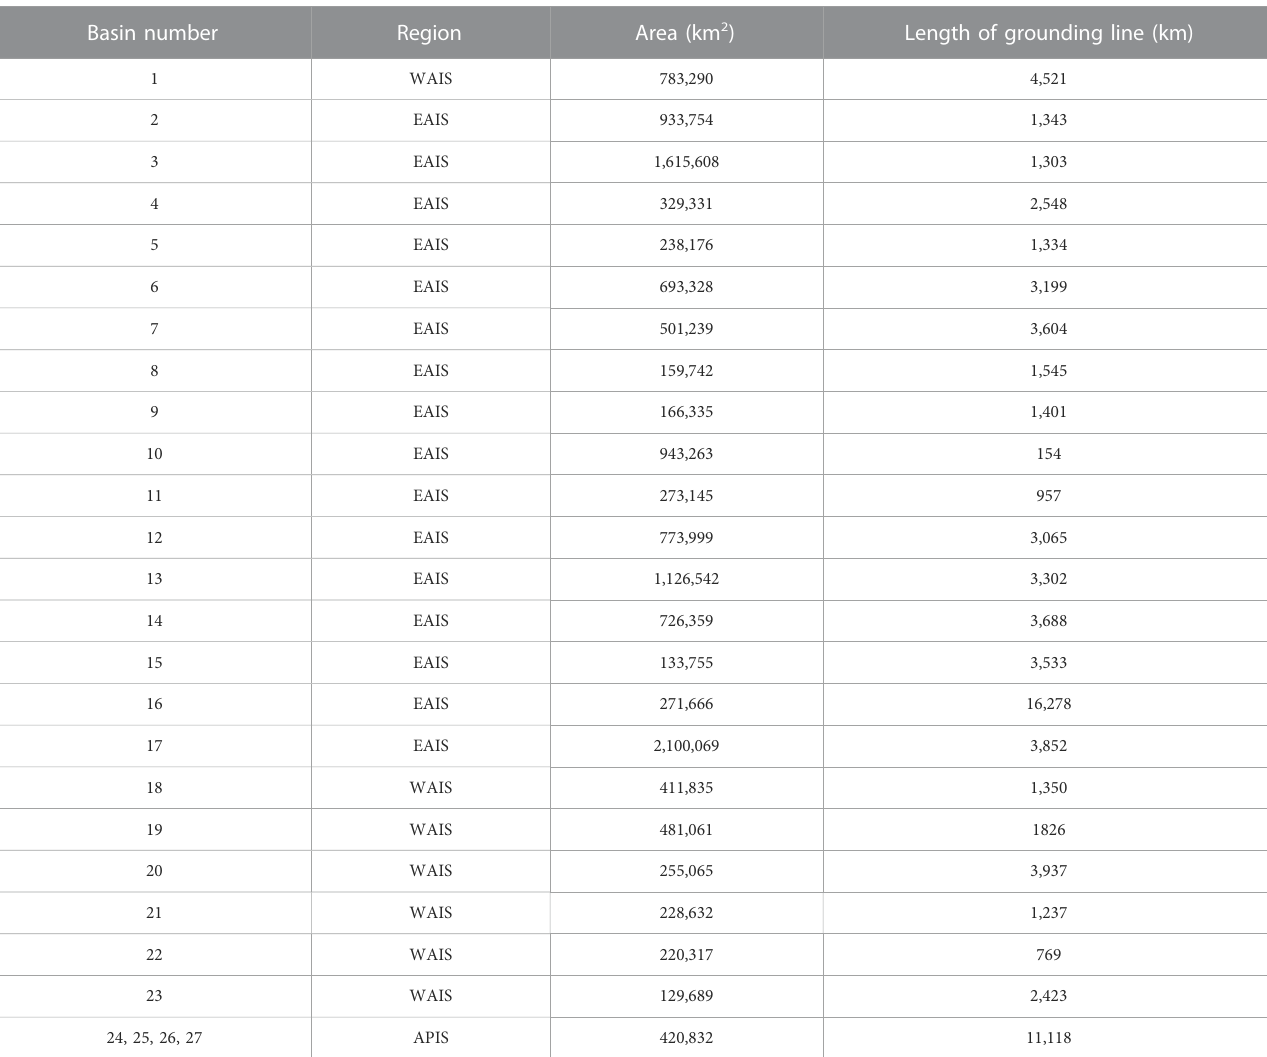
TABLE 3 Description of the basins over